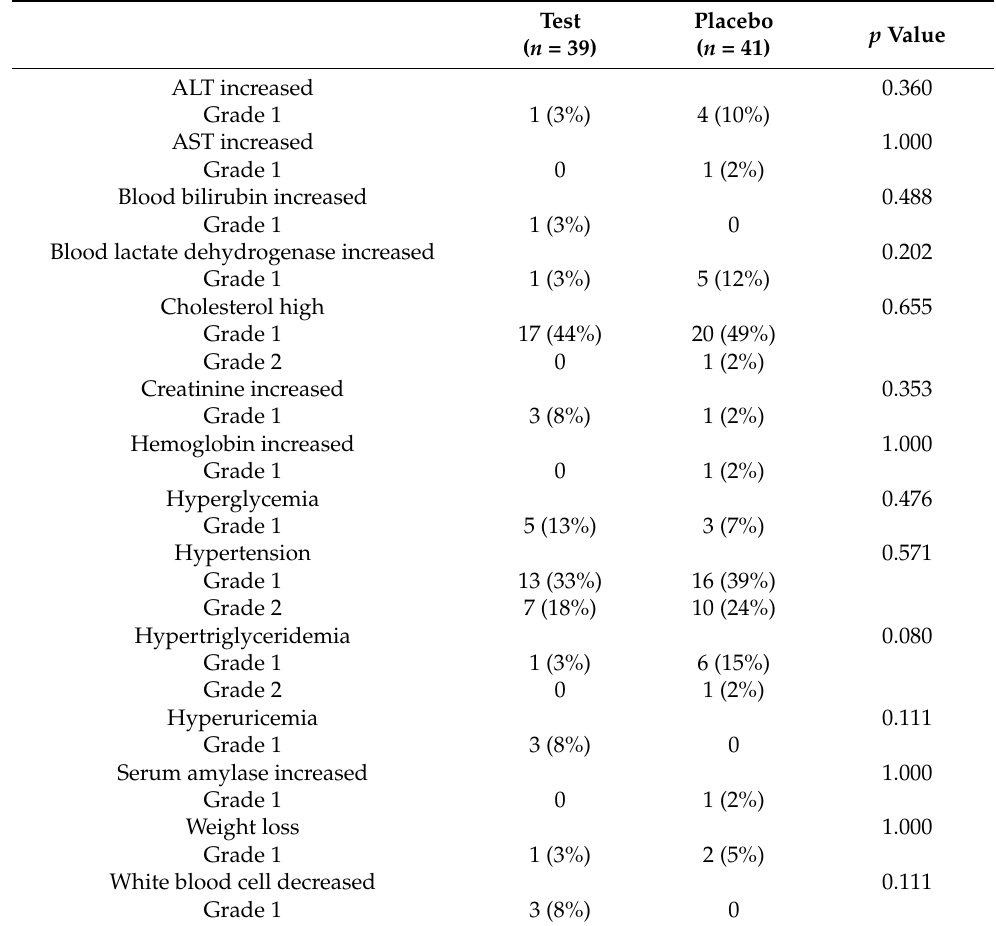
Table 3. Number and ratio of participants who show adverse events that have possible relation to the study design or